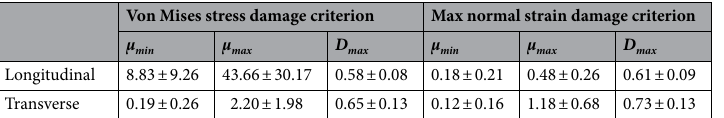
Table 1. Damage parameters for models loaded longitudinal or transverse to the preferred fiber direction.